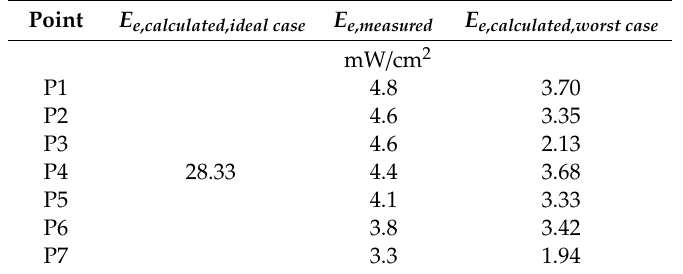
Figure 9. Location of irradiation measurement points during validation. Table 1. Results of irradiation measurement during validation procedure.